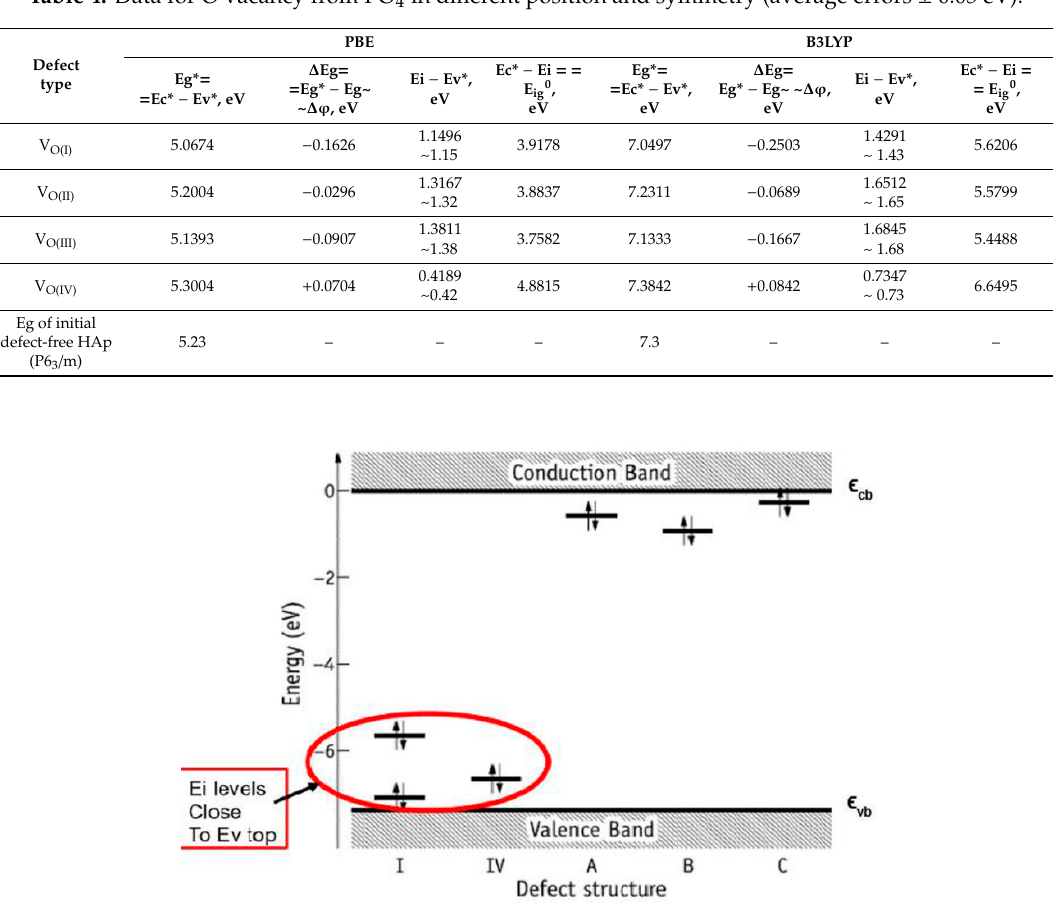
Figure 14. Kohn − Sham energy levels of neutral V O defects in a HAp supercell at the k = Γ point. The defect structure I is also representative of structures II and III (see text). The latter have gap states that deviate from those of V O(I) by less than 0.2 eV [35]. Reprinted and modified with permission from [35]. Copyright (2019) American Chemical Society.